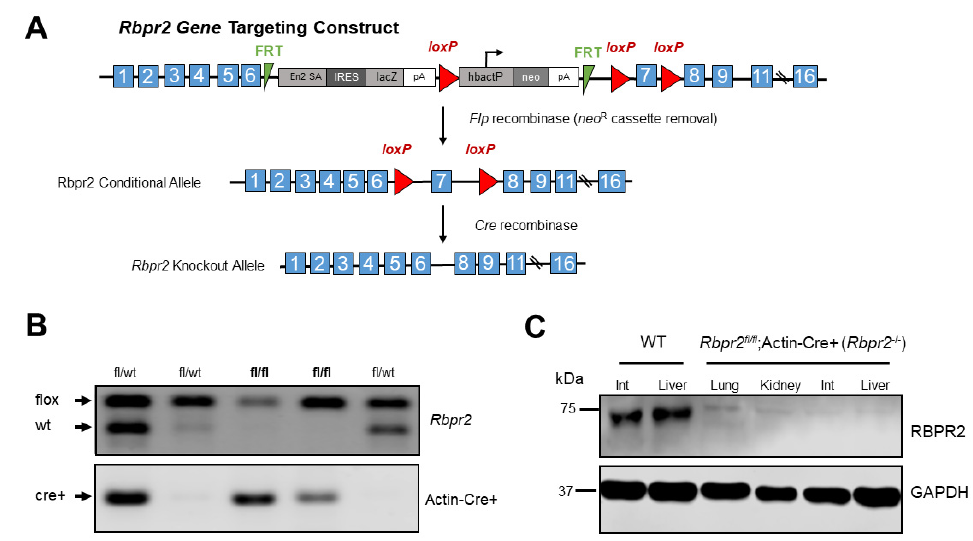
Figure 1. Disruption of the mouse Rbpr2 gene using the Cre/LoxP strategy and generation of the global Rbpr2 knockout ( Rbpr2 − / − ) mice. ( A ) An Rbpr2 targeting vector was designed to replace exon 7 with a neomycin cassette ( neo R ) flanked by loxP sites. This resulted in the Rbpr2 neo R cassette allele. The neo R cassette was floxed out by mating Rbpr2 fl/wt mice with the Rosa flp/flp mice. The Rbpr2 fl/fl mice were then mated with Actin-Cre+ mice to finally generate littermate controls and the global Rbpr2 knockout (annotated as Rbpr2 − / − ) mice. ( B ) PCR-based genotyping for identifying the Rbpr2 fl/fl ; Actin-Cre+ ( Rbpr2 − / − ) and littermate control mice. ( C ) A custom made RBPR2 antibody was generated and used to determine the systemic loss of RBPR2 protein expression in Rbpr2 − / − mice. Immunoblot of protein extracts of tissues from adult WT and Rbpr2 − / − mice. Pooled protein from n = 3 mice (per genotype) at 6–8 weeks of age. GAPDH antibody was used as the loading control. Int, intestine; WT, wild-type.